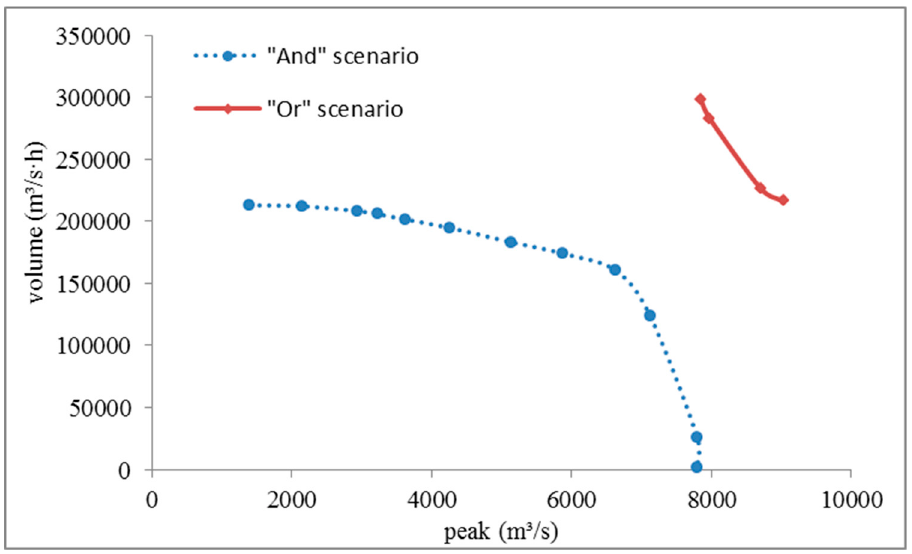
Figure 11. Peak–volume combinations with a 0.01 frequency in C and and C or scenarios.